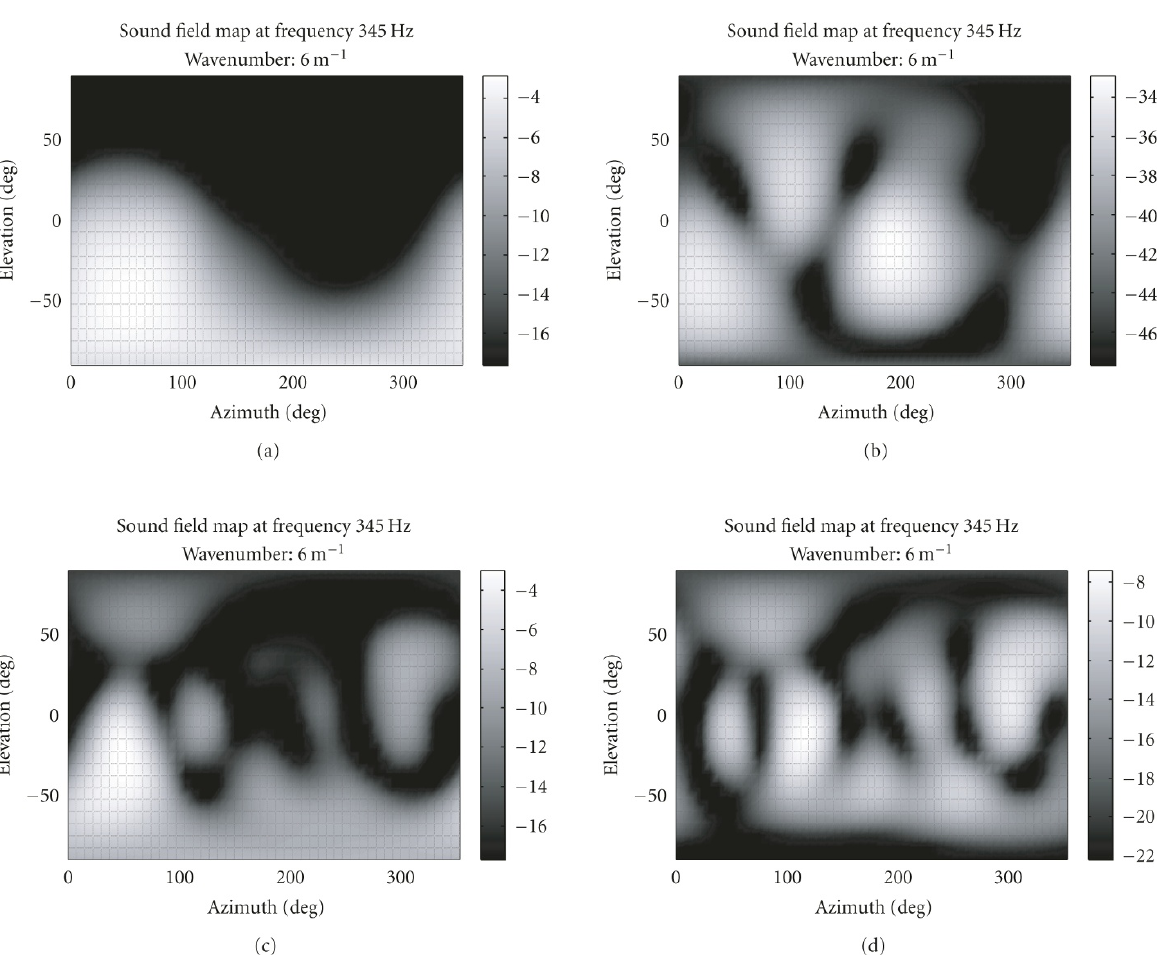
Figure 6: Influence of sensor noise on sound field cartographies for a point source located at [ r = 1 . 5m, az = 52dg, el = − 46dg], for frequency 345 Hz, with initial SNR = 30dB. Sound field regularized (a), error sound field regularized (b), sound field nonregularized (c), and error sound field nonregularized